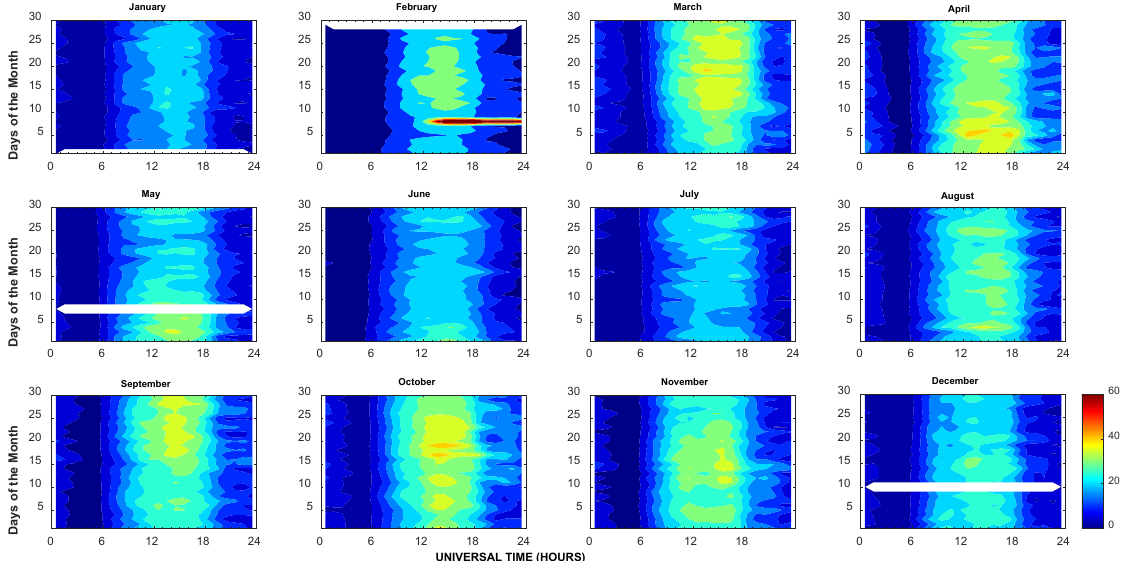
Figure 6. Monthly TEC variation over the BJCO receiver during a low-solar-activity period (2010).